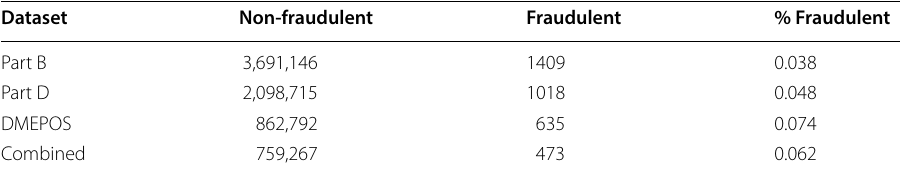
Table 9 Distribution of fraud